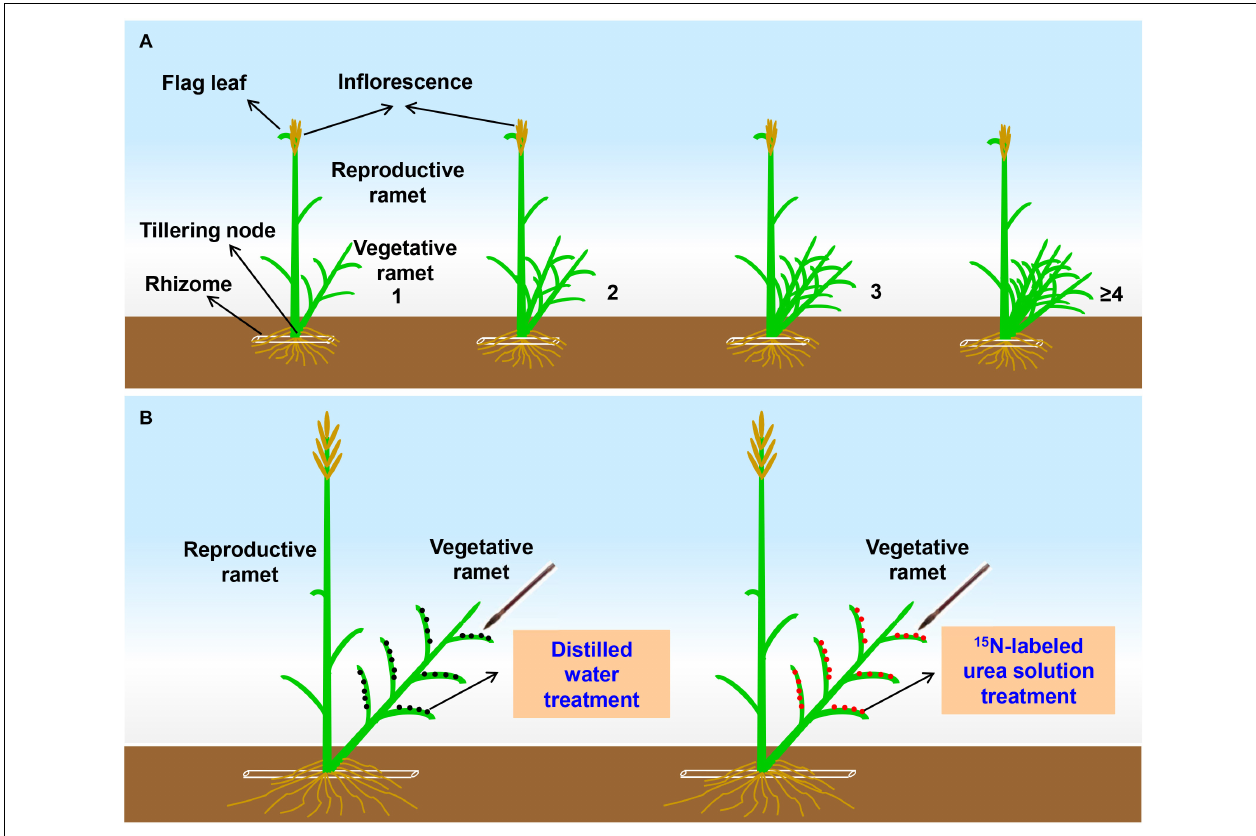
FIGURE 1 | (A) Schematic representation of the tagging experimental design at the early heading stage of Leymus chinensis . The Arabic numerals represent the number of vegetative ramets connected to a tillering node of the reproductive ramet. In each gradient, inflorescence top of the reproductive ramet reaches approximately 2 cm over the flag leaf sheath. (B) Schematic representation of the stable-isotope ( 15 N) labeling experimental design at the seed-filling stage of Leymus chinensis . Each ramet pair consists of one reproductive ramet and one vegetative ramet connected by a tillering node (which refers to unelongated basal internode of the